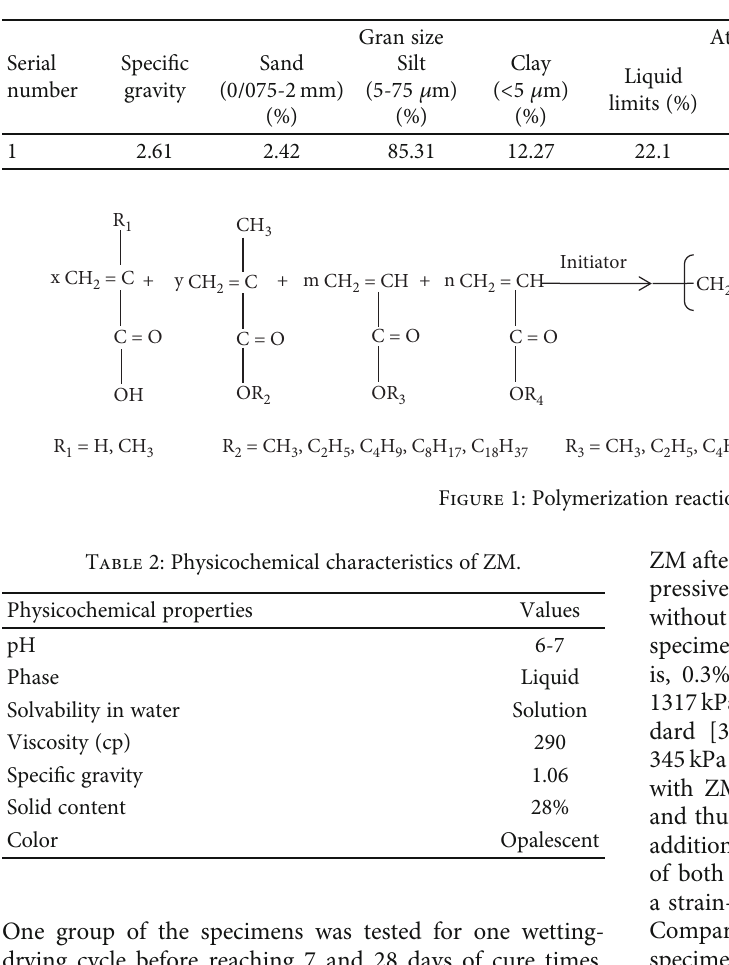
Table 1: Soil characteristics.